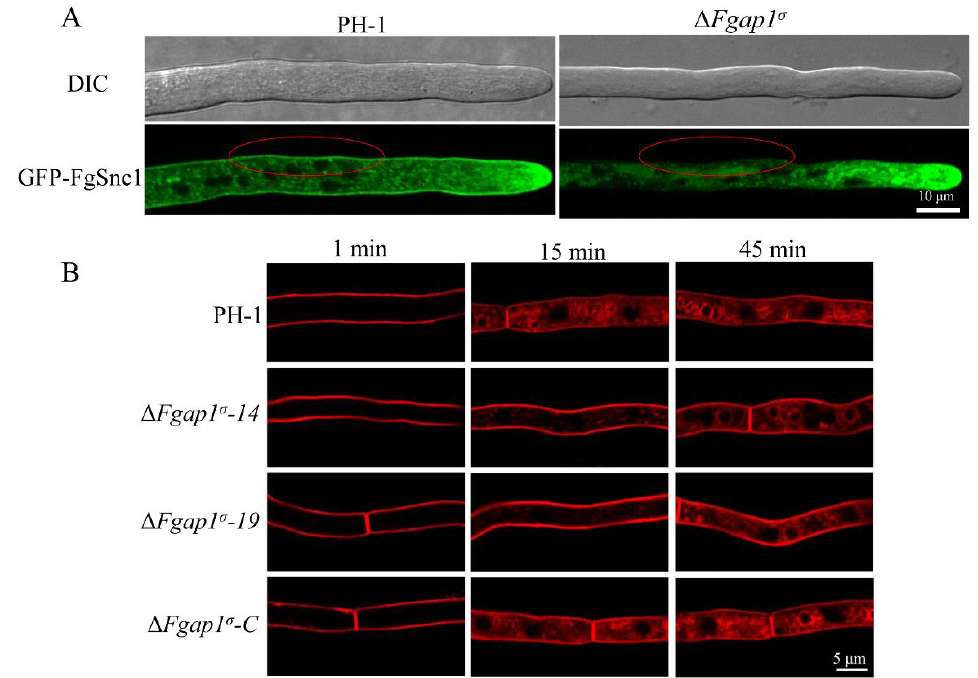
Figure 8. FgAP1 σ is involved in exocytosis and endocytosis processes. ( A ) The plasma membrane localization of GFP-FgSnc1 is disrupted in the ∆ Fgap1 σ mutant, as indicated by red circles. Bar = 10 µ m. ( B ) FgAP1 σ delays internalization of FM4-64 into the vacuole membrane. Hyphae of the wild-type PH-1, ∆ Fgap1 σ -14, ∆ Fgap1 σ -19, and complement strain ∆ Fgap1 σ -C were cultured in liquid CM for 24 h and then stained with FM4-64 and observed at different time points using a fluorescence confocal microscope. Bar = 5 μm.